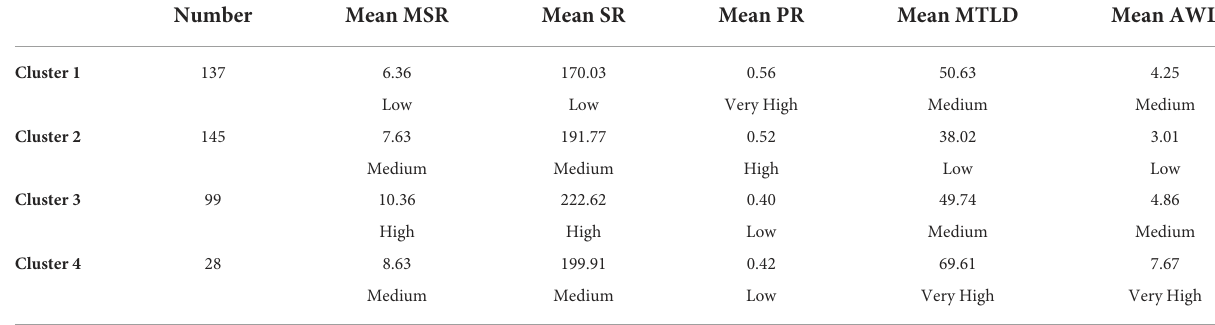
TABLE 8 Descriptive statistics of fluency and vocabulary measures across clusters.